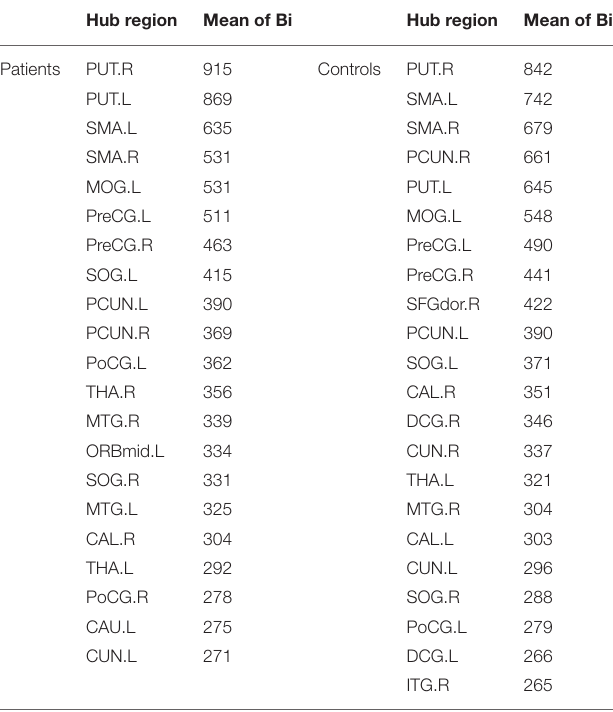
TABLE 3 | Hub regions in the cerebellar infarction and control group. Hub region Mean of Bi Hub region Mean of Bi